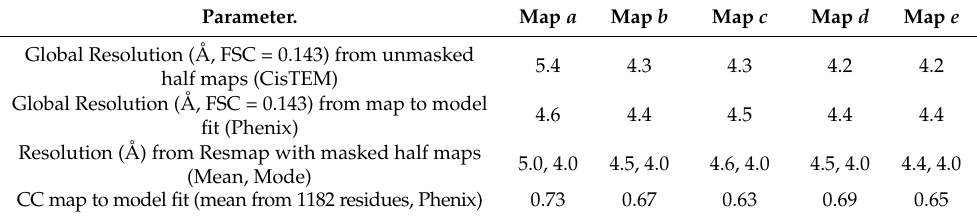
Table 1. Summary of all the data for reciprocal space resolution assessment of the five maps as well as the real-space correlation coefficient (CC) between the atomic model and the relevant map. Parameter. Map a Map b Map c Map d Map e Global Resolution (Å, FSC = 0.143) from unmasked 5.4 4.3 4.3 4.2 4.2 half maps (CisTEM) Global Resolution (Å, FSC = 0.143) from map to model fit (Phenix)